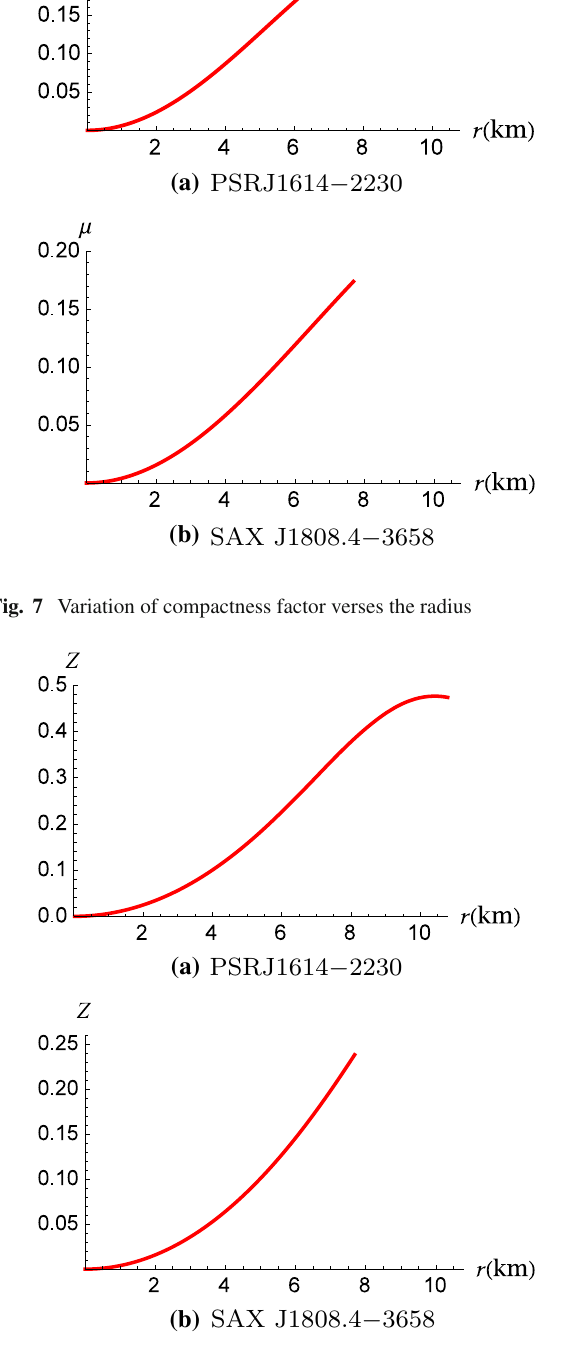
Fig. 8 Variation of surface redshift function verses the radius and monotonically decreasing with the radius. In Fig. 3 the radial and tangential pressures p r and p t are shown respec- tively for PSR J1614-2230 and SAX J1808.4-3658. They are